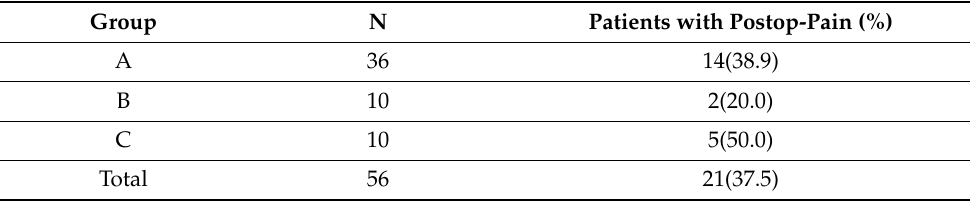
Table 5. Postoperative pain and anesthesia. Group N Patients with Postop-Pain